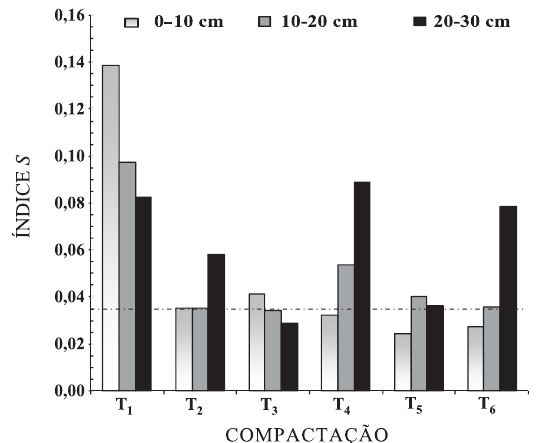
Figura 1. Índice S em diferentes profundidades de um Latossolo Vermelho submetido à compactação: T1 = solo preparado (escarificação e gradagem), sem tráfego de tratores; T2 = uma passada do trator de 4 t; T3 = uma passada do trator de 6 t; T4 = duas passadas do trator de 6 t; T5 = quatro passadas do trator de 6 t; T6 = oito passadas do trator de 6